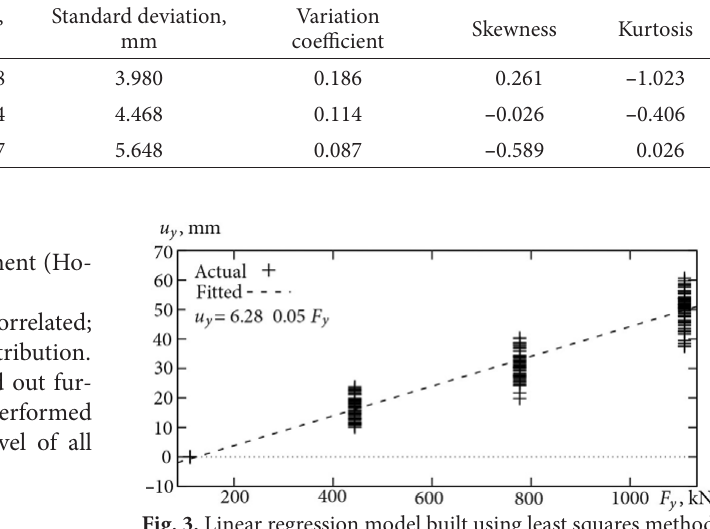
Table 3. Probability distribution parameters of measured displacements for the particular stressing force level Stressing force level, kN